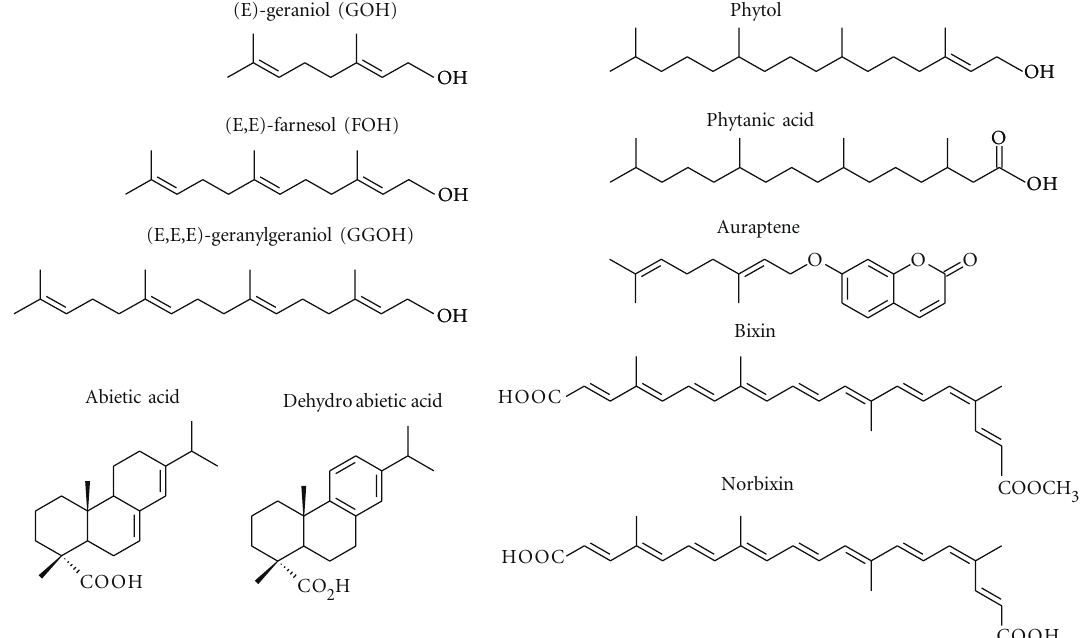
Figure 2: Chemical structures described in this